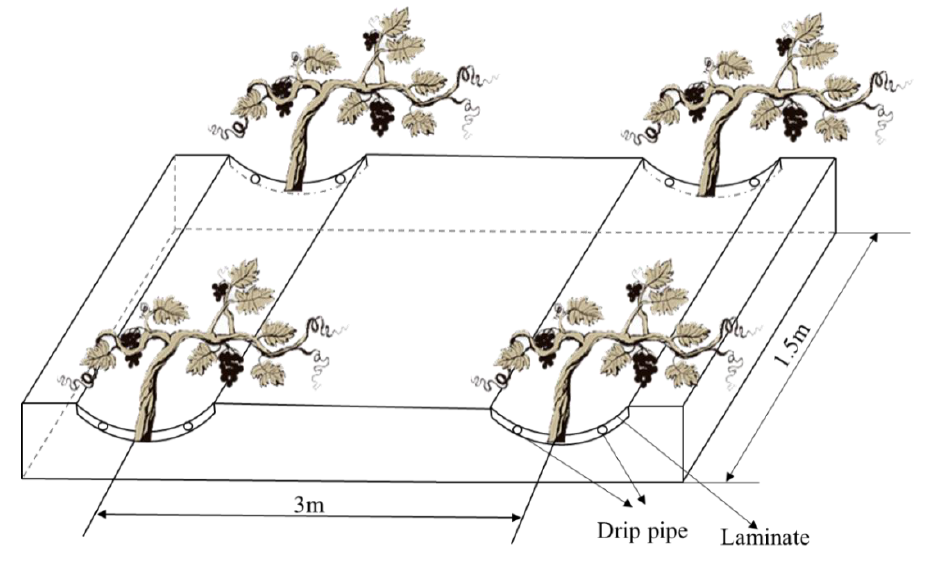
Figure 1. Vine planting scheme.